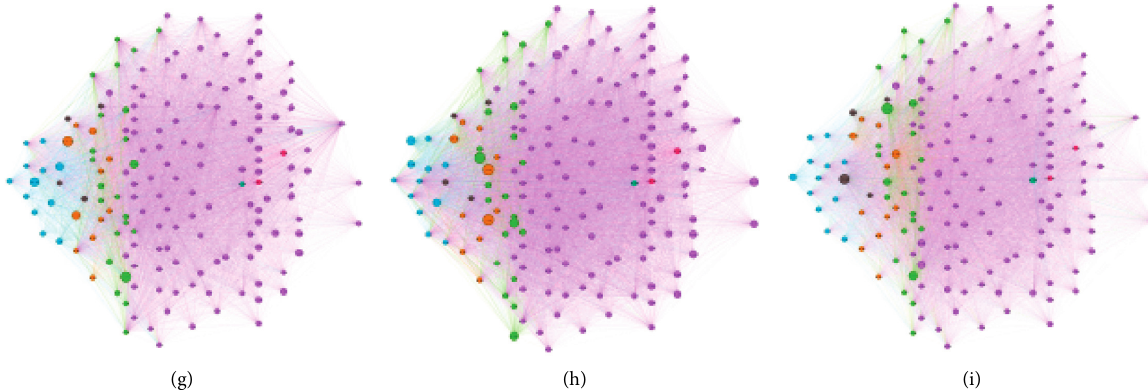
Figure 17: Some layers of our multiplex based on IR ) show normalized area-related characteristics. (b) ( IR nodes (a) ( IR 6 shows the binary normalized area contrast characteristics. (d) ( IR binary HUE (RYB color space) color palette contrast characteristics. (f) ( IR ) shows the binary saturation color palette contrast characteristics. (h) ( IR acteristics. (g) ( IR 20 ) region. (i) ( IR 22